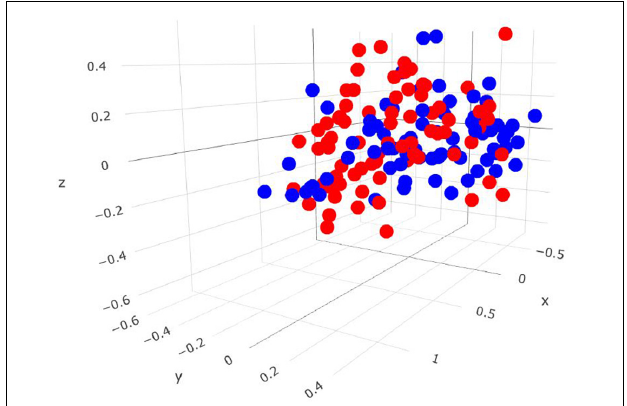
FIGURE 3 | Three-dimensional Bray-Curtis NMDS plot highlighting differences in the bacterial community composition between animals ranked as high and low for residual methane emissions. Red = low RME; blue = high RME.